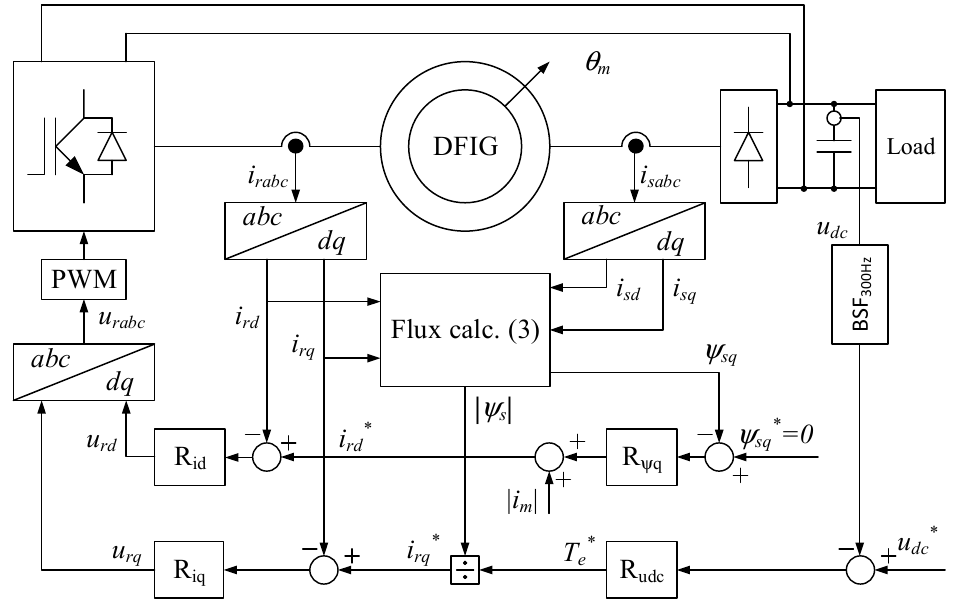
Figure 2. Stand-alone DFIG-DC voltage generator controlled with field-oriented vector control.